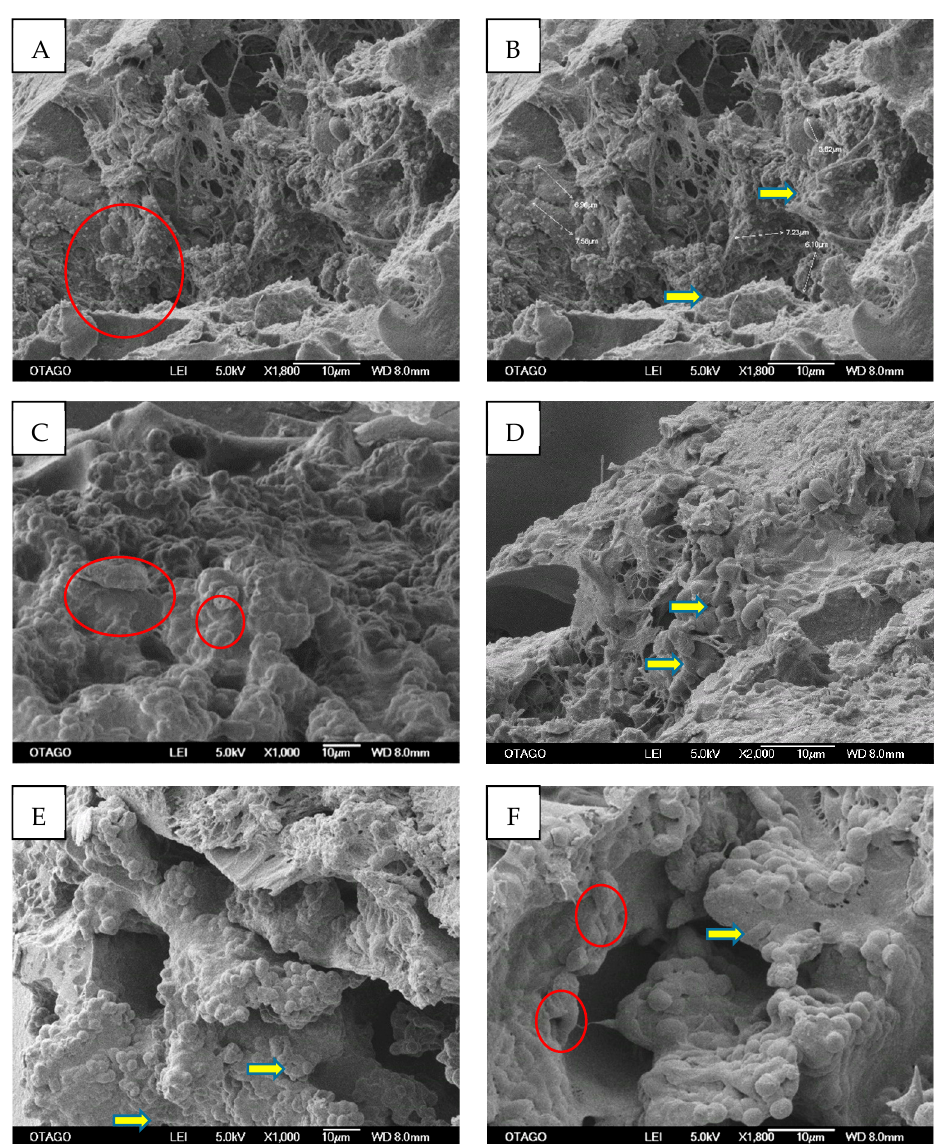
Figure 6. Representative SEM micrographs of cross-sections of intact Ly-PRF revealed entrapped clusters of platelets (yellow arrows) and leukocytes (red circles) within the Ly-PRF clot. ( A ) Repre- sentative image of a zone of enriched platelets with various degrees of activation. (SEM; original magnification: ( A , B ) ×1800, ( C ) ×1000, ( D ) ×2000, ( E ) ×1000 and ( F ) ×1800). (Bar = 10 µm).